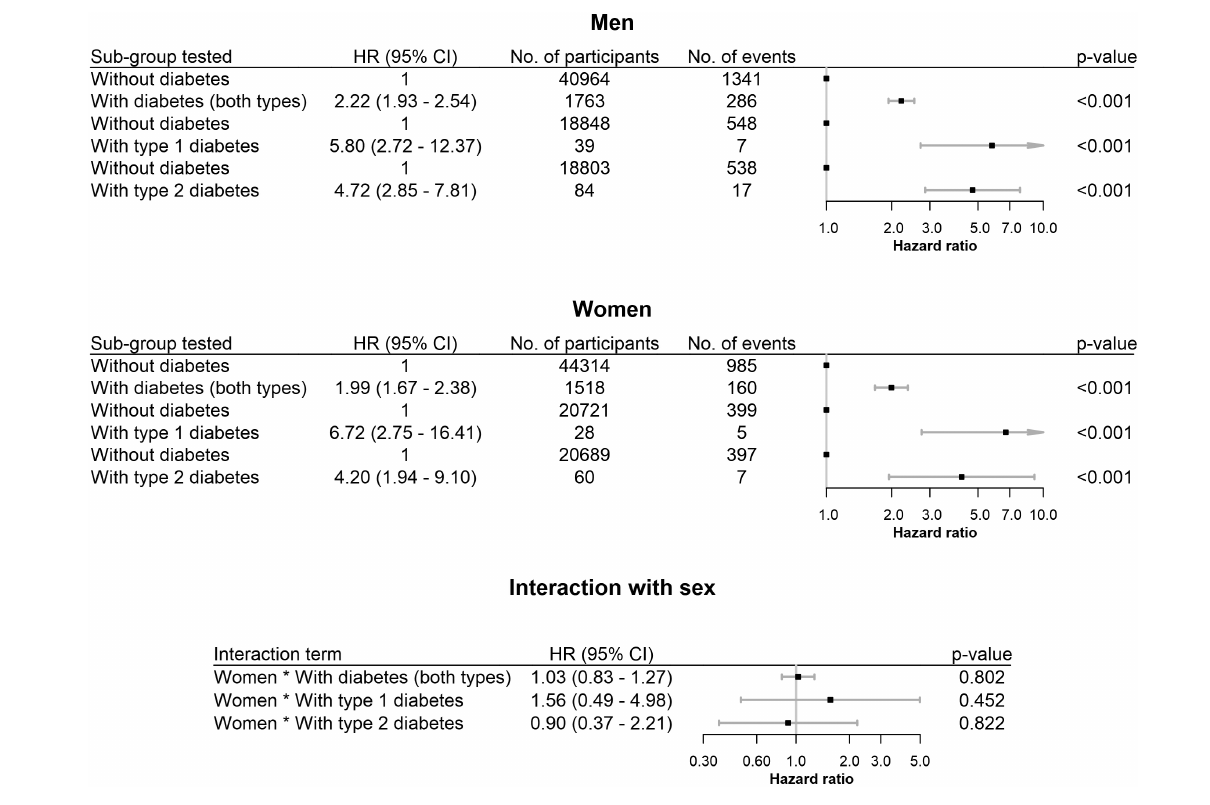
FIGURE 3 Hazard ratios (HR) with 95% con fi dence intervals (CI) for diabetes and sex and diabetes interactions on heart failure. Results are from separate models for men, women and both sexes and different types of diabetes adjusted for age, hypertension, hypercholesterolemia, smoking, BMI, alcohol use and coronary artery disease at baseline. Models with both types of diabetes combined use all the cohorts, whereas models with separate variables for type 1 and type 2 diabetes use only cohorts from DAN-MONICA and FINRISK